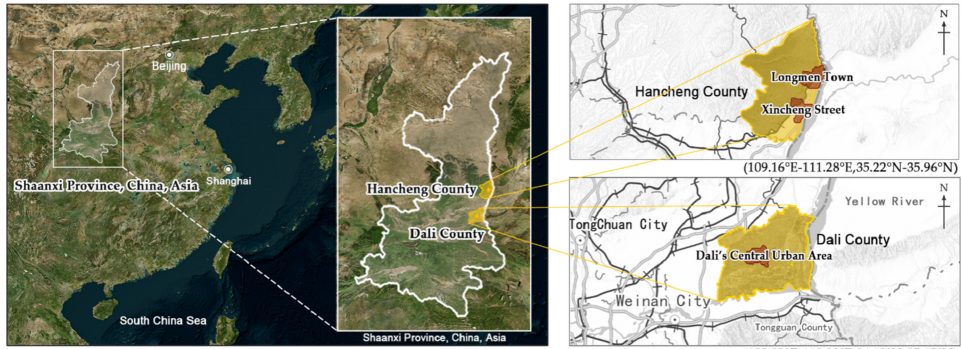
Figure 1. Schematic diagram of the study